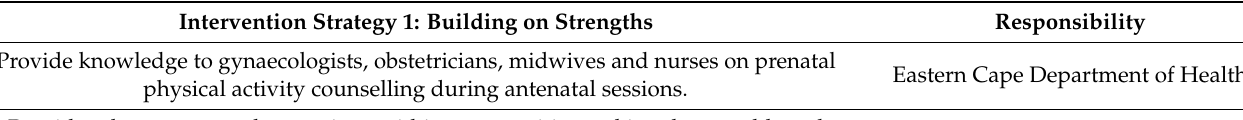
Table 3. Developed physical activity intervention